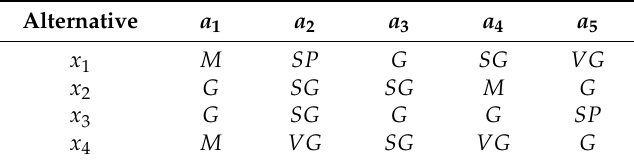
Table 3. Linguistic-term-based decision matrix R 3 =